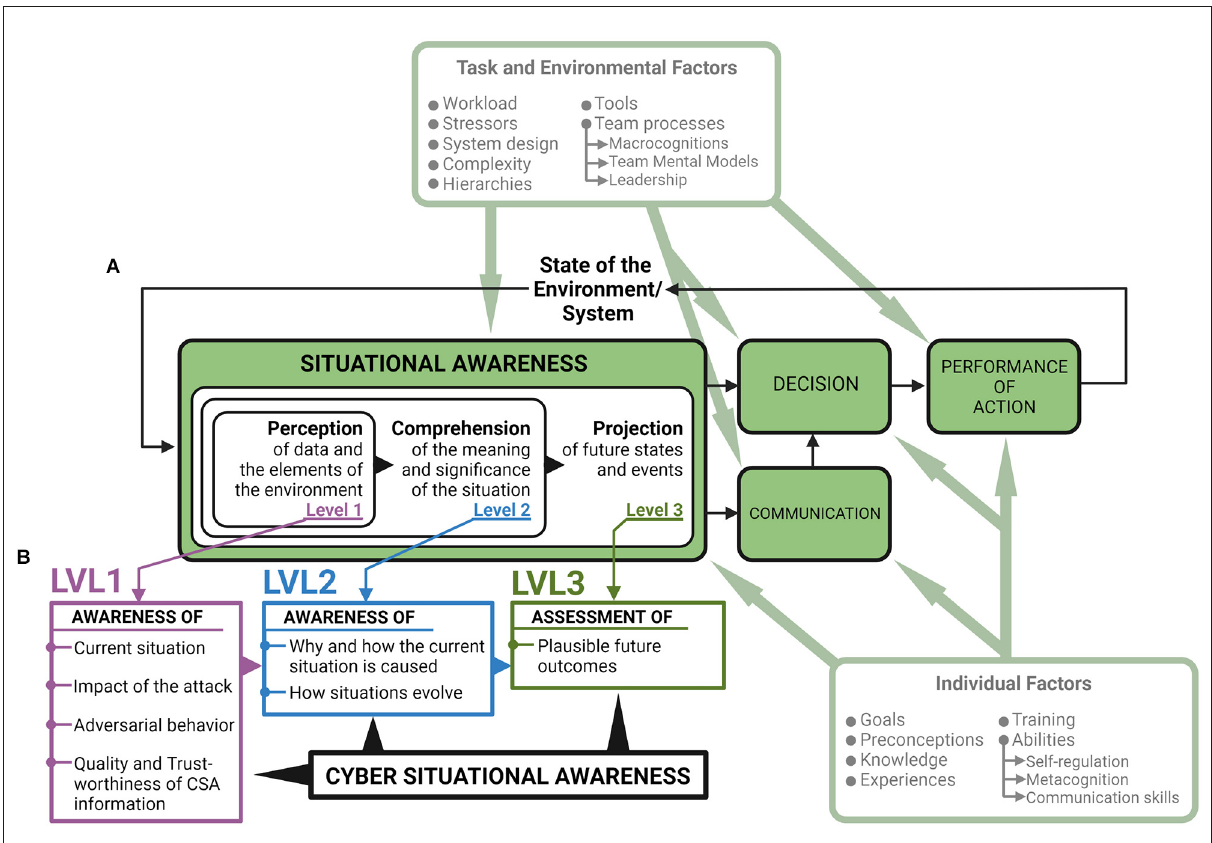
FIGURE1 Situational Awareness (SA) model with suggested requirements for achieving Cyber Situational Awareness (CSA). (A) The SA model (Endsley, 1995). Communication has been added to the model due to its role in Security Operation Center (SOC) team decision-making (Knox et al., 2018; Ask et al., 2021a). (B) Seven requirements for achieving CSA during cyber threat situations (Barford et al., 2009). CSA generation, CSA sharing, and subsequent decision-making is affected by individual factors such as metacognition, self-regulation, and communication skills (Jøsok et al., 2016, 2019; Knox et al., 2017, 2018, 2019; Sütterlin et al., 2022) and task and environmental factors such as team-processes including macrocognitions, team mental models, and leadership (Jøsok et al., 2017; Lugo et al., 2017a; Ask et al., 2021a,b). Modified from Lankton